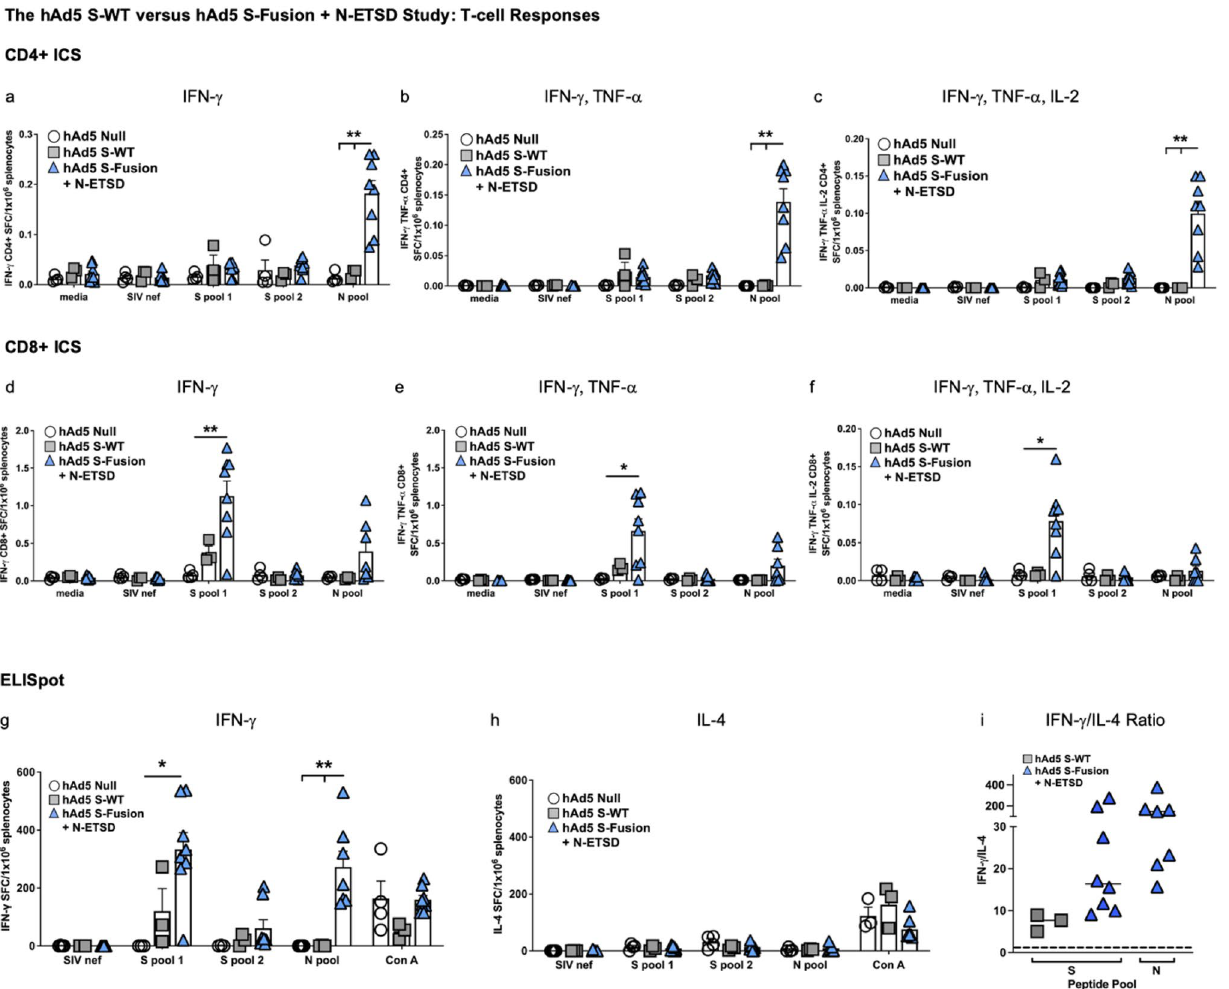
Figure 3. T‑cell responses to S are greater for hAd5 S‑Fusion + N‑ETSD as compared to hAd5 S‑WT and CD4 + T cells were more responsive to N . Intracellular cytokine staining (ICS) of interferon-γ (IFN-γ), IFN-γ/tumor necrosis factor α (TNF-α), and IFN-γ/TNF-α/interleukin-2 (IL-2) in response to S peptide pools 1 and 2 as well as the N peptide pool is shown for ( a – c ) CD4 + and ( d – f ) CD8β + T lymphocytes. CD4 + T cells were more responsive to N peptides and CD8 + T cells to S peptide pool 1 that contains the S RBD as compared to S peptide pool 2 or the N pool. Media and SIV nef are negative controls. ELISpot detection of ( g ) IFN-γ secretion by T-lymphocytes also reveals responses to S peptide pool 1 and the N pool. ( h ) Interleukin-4 (IL-4) secretion was very low. SIV nef is a negative control and Con A a positive control. ( i ) The IFN-γ/IL-4 ratios of > 1 (dashed line) reflects the Th1 bias of all T-cell responses. hAd5 Null n = 4, hAd5 S-WT n = 3, and hAd5 S-Fusion + N-ETSD n = 8. Statistical analyses performed using one-way ANOVA with Dunnett’s post-hoc comparison of the S-Fusion + N-ETSD group to the S-WT or Null groups, where * p < 0.05 and ** p ≤ 0.01. Data graphed as the mean with